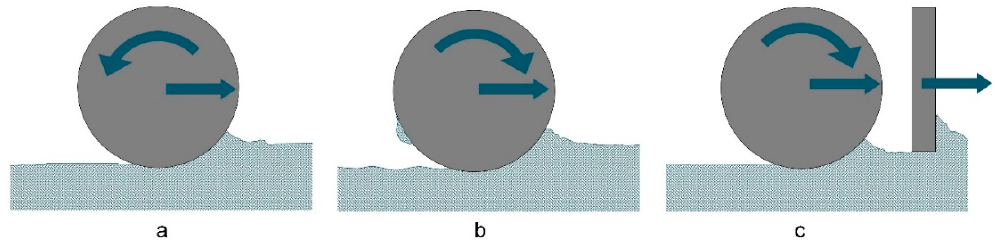
Figure 3. ( a ) Counter-rotating roller; ( b ) forward-rotating roller causing defects in the powder bed; and ( c ) combination of blade and roller (modificated 36).